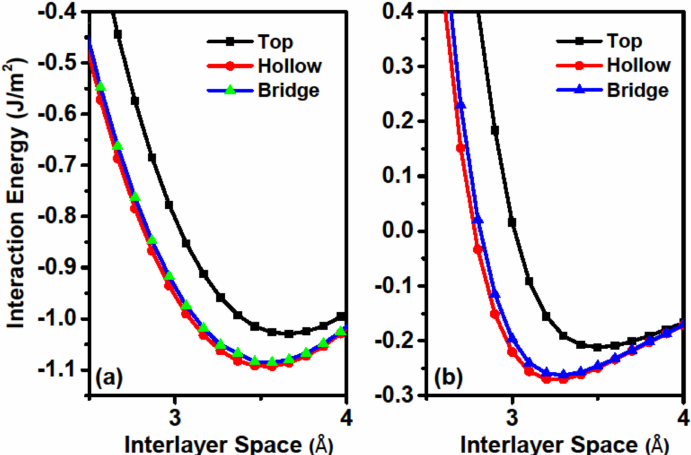
Figure 2. Interaction energy (IE) as a function of interfacial space d between two sheets of ( a ) Ca 2 N and ( b ) graphene, respectively. It should be noticed that the two parts have different y-axis scales.